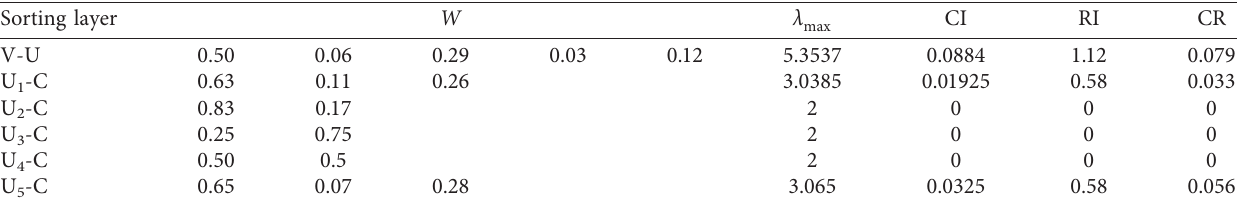
Table 9: Calculation results of hierarchical single sorting.